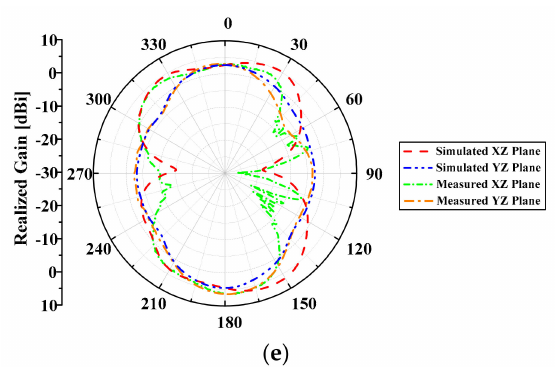
Figure 17. Simulated and measured radiation patterns of the UWB antenna for various frequencies: ( a ) at 3.5 GHz; ( b ) at 4.9 GHz; ( c ) at 6.52 GHz; ( d ) at 7.65 GHz; € at 9.5 GHz. Figure 18 shows the simulated and measured radiation patterns of the NB antennas at 3.5 GHz, 4.9 GHz, 6.52 GHz, 7.65 GHz, and 9.5 GHz. The NB antennas have quasi-omnidirectional radiation patterns in the YZ plane.